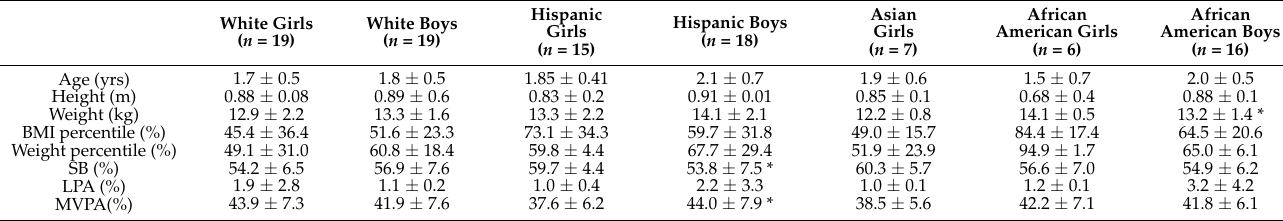
Table 2. Participant characteristics by